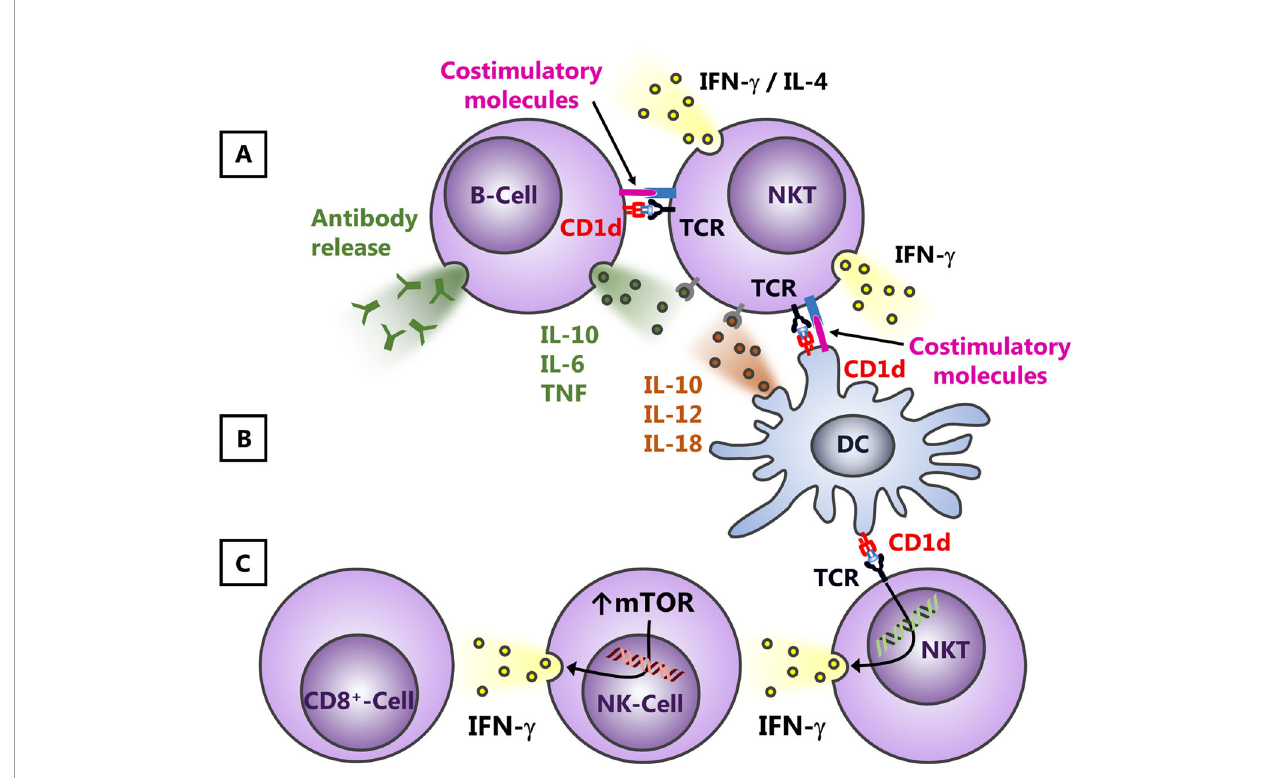
FIGURE 2 | Effects of NKT cell activation on B-lymphocytes and NK cells. NKT cells and antigen presenting cells such as B-lymphocytes (A) or DCs (B) in fl uence each other due to cognate and bystander activation. Thus, on the one hand, B-lymphocytes and DCs can modify NKT cell responses due to variations in the presentation of lipid antigens and/or an altered release of cytokines and/or changes in the expression of costimulatory molecules. B cells can promote thereby also Th2 responses (A) , whereas DCs presumably trigger predominantly the release of Th1 cytokines (B) . Vice versa, dependent on the interaction with cytokines, costimulatory molecules and/or the lipid antigens presented, NKT cells, for example, can alter their cytokine pro fi le (Th1 and Th2) and subsequently suppress or augment B cell responses. This can affect the release and/or the class switch of antibodies by B-lymphocytes (A) or the cytokine pro fi le and/or expression of costimulatory molecules by DCs (B) . Within a more Th1-dominated cytokine milieu, NKT cells can cross-activate NK cells and CD8 + T-lymphocytes (C) , a process that involves IFN- g . This release of cytokines by NKT cells, however, does not only augment subsequent immune responses, but can also contribute to immunosuppression, for example, due to the upregulation of